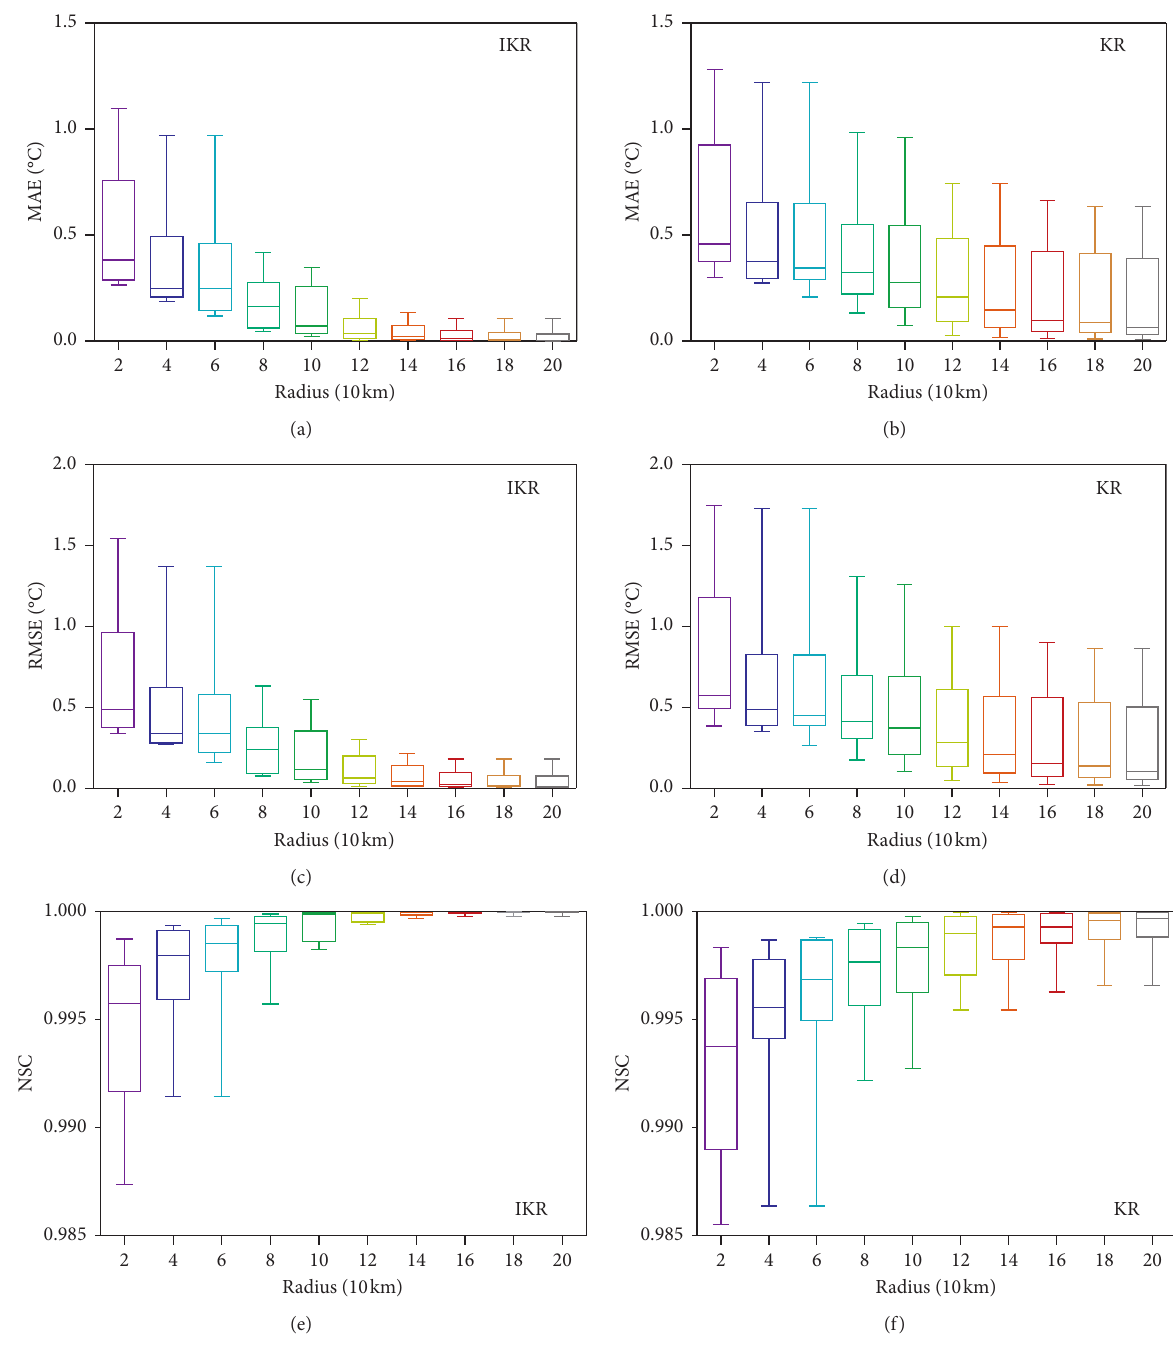
Figure 4: Comparison of the IKR and KR methods in terms of different indicators: (a, b) MAE; (c, d) RMSE; (e, f)